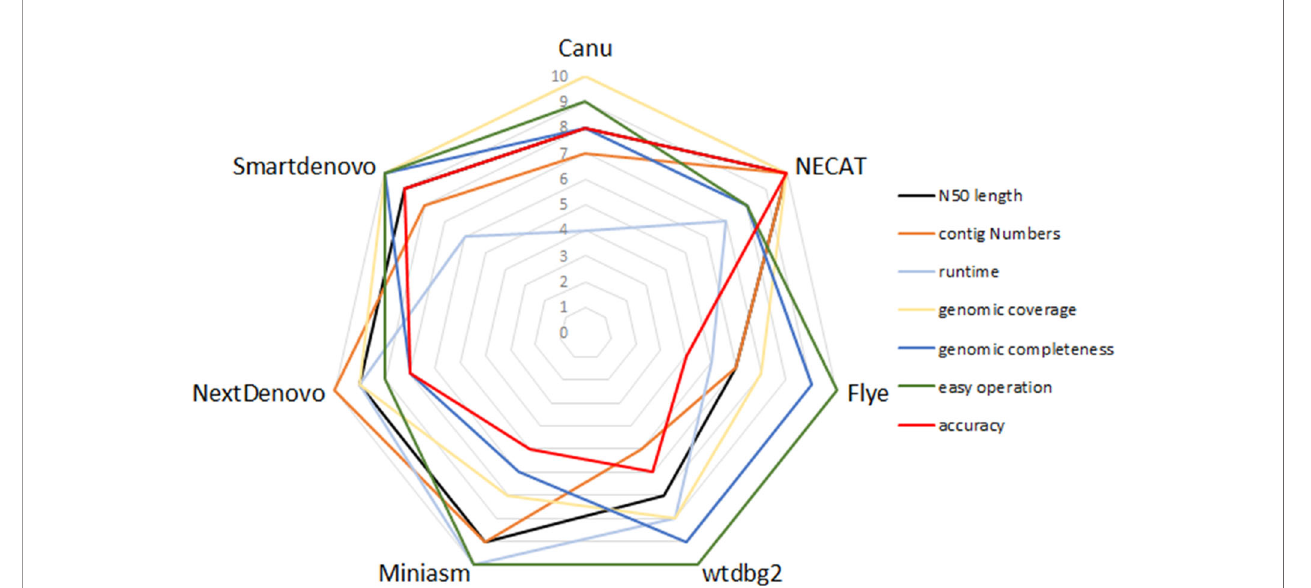
FIGURE 3 | Relative performance of de novo assemblers in terms of quality of genome and